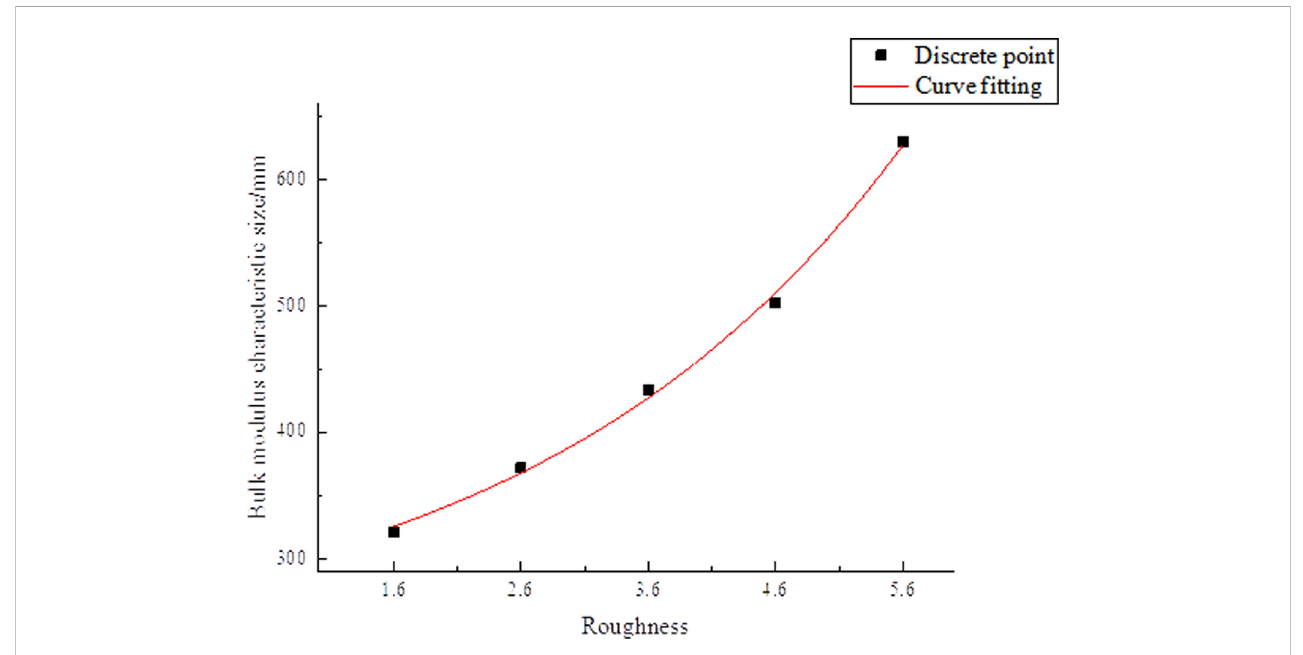
FIGURE 8 Fitting curve between the CSBM and